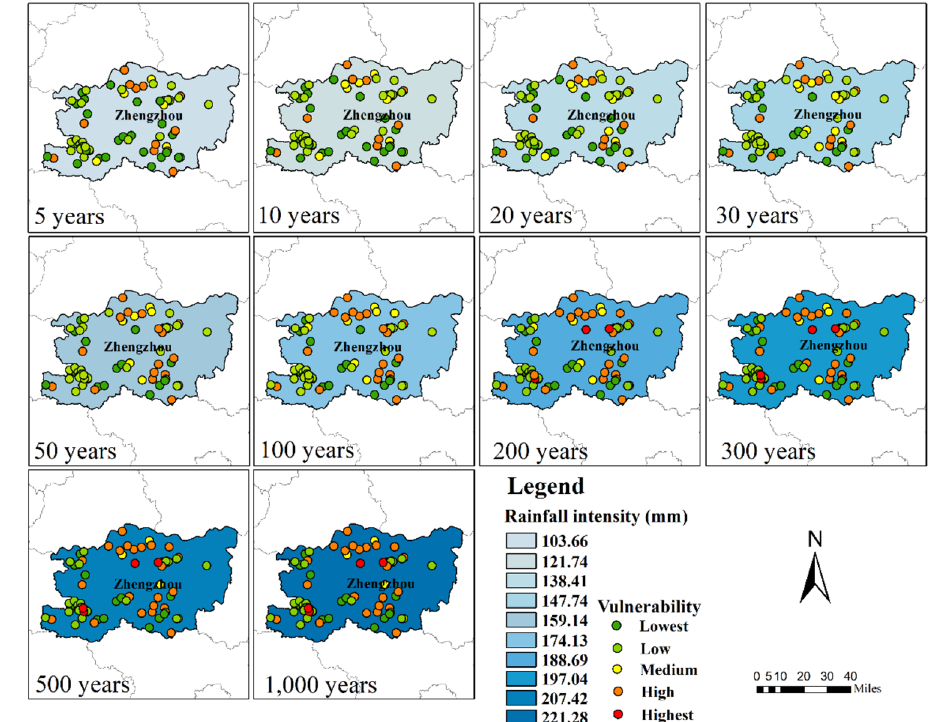
Fig. 6 Prediction results for cultural relic vulnerability for different recurrence periods (5 years to 1000 years) of heavy rainfall in Zhengzhou City, Henan